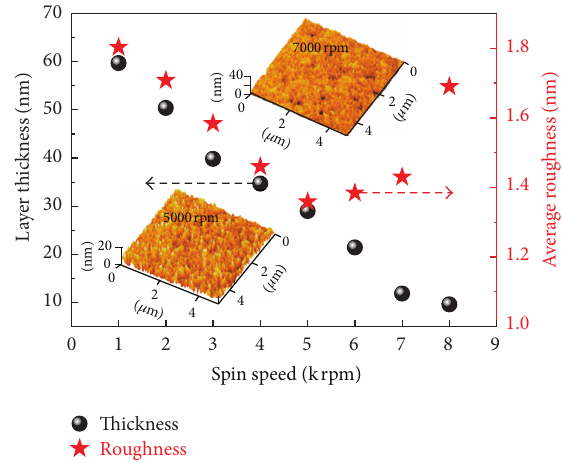
Figure 3: Layer thickness and average roughness for various PEDOT:PSS films fabricated at 1000 to 8000 rpm on Ag-AgO 𝑥 anode. The inset DFM photos show the surface of 5000 and 7000 rpm